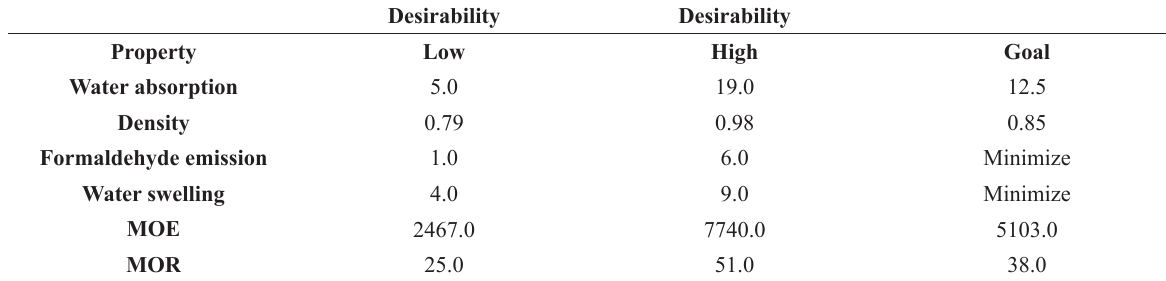
Property optimization goals.